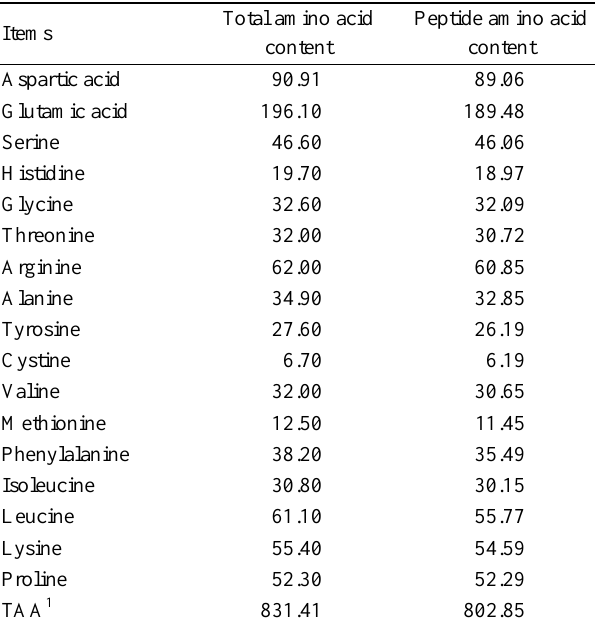
Table 1. The concentration (mg/g) of total amino acids and peptide amino acids in soybean small peptides